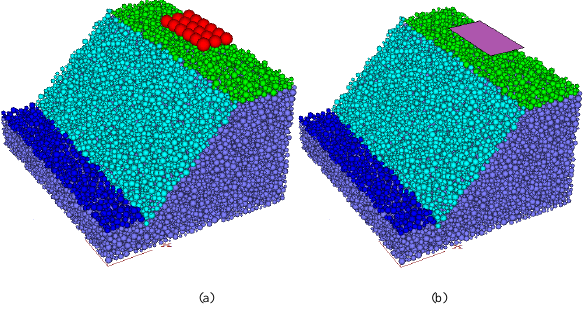
Figure 8. Two loading patterns of simulation models: (a) applying Figure 8 Two loading patterns of simulation models: (a) applying the force on the raft footing; (b) the force on the raft footing; (b) adding velocity on the loading wall. adding velocity on the loading wall.